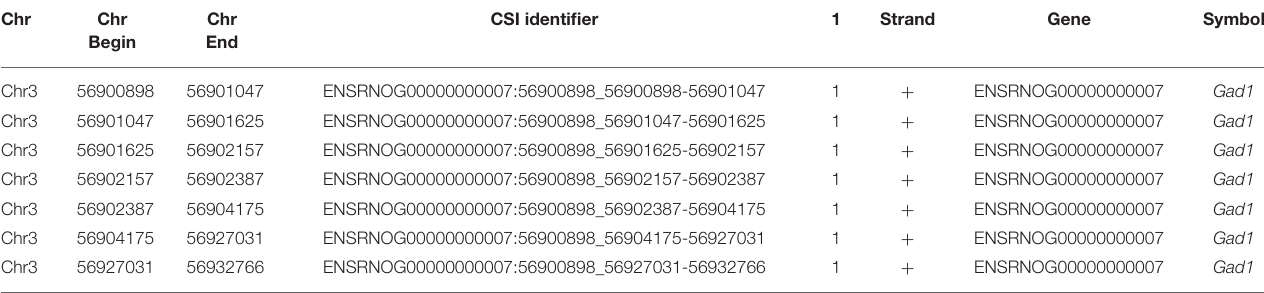
TABLE 3 | Example CSI BED file for GAD1 .